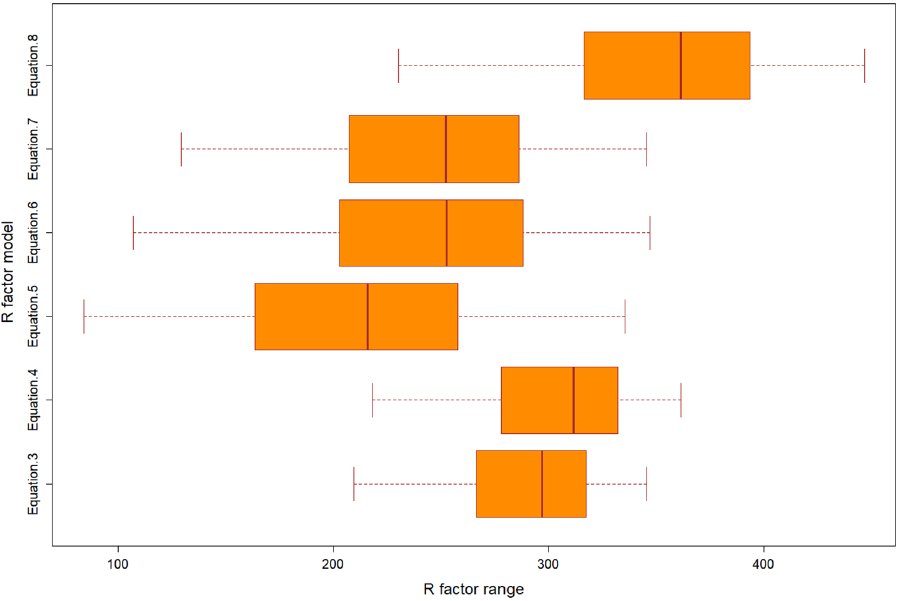
Figure 4. The distribution of the (A) R-factor (Equation (5)) and (B) K-factor maps within the DLB for 2 May 2008.